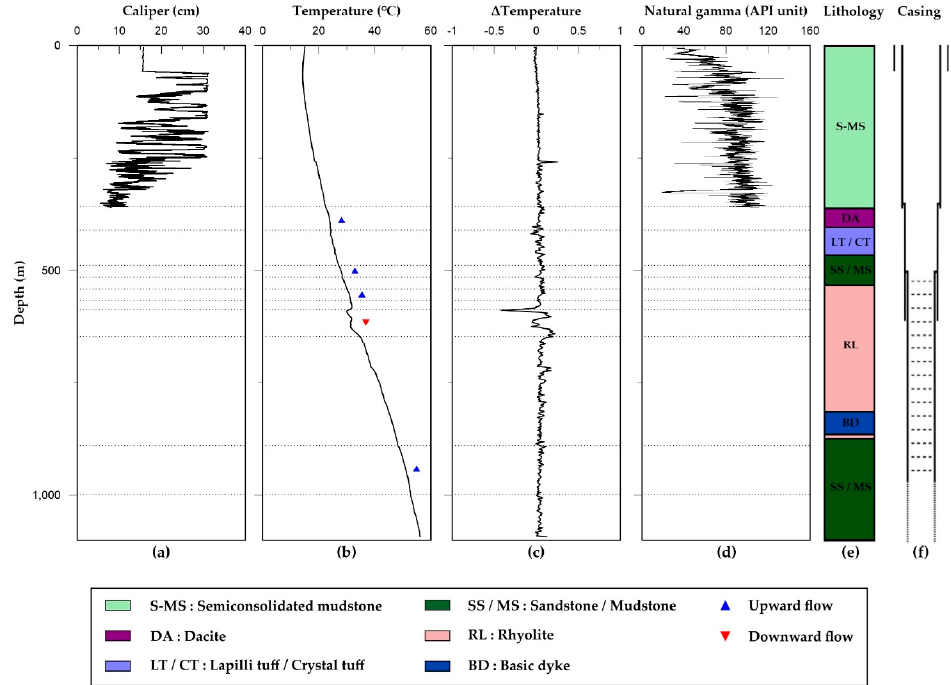
Figure 5. Geophysical and lithological profiles of BH-1: ( a ) Caliper log; ( b ) temperature log; ( c ) delta temperature log; ( d ) natural gamma-ray log; ( e ) a simplified lithological log; and ( f ) a casing installation. The blue triangle indicates upward ground flow, and the red upside-down triangle indicates downward ground flow. Estimated depth intervals where groundwater flows occurred are marked with dotted lines.